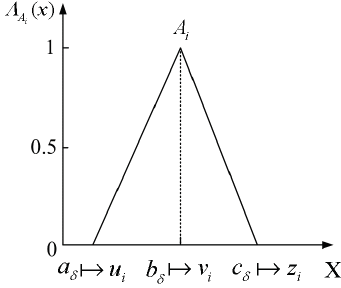
Figure 5. Membership function of